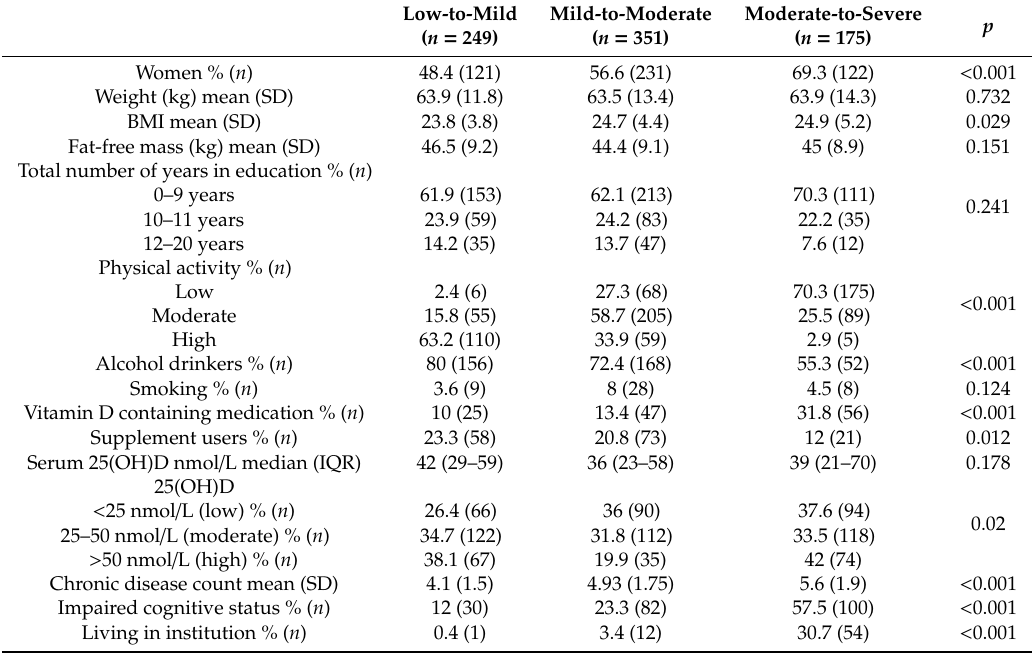
Table 1. Participant characteristics by the three disability trajectories identified at